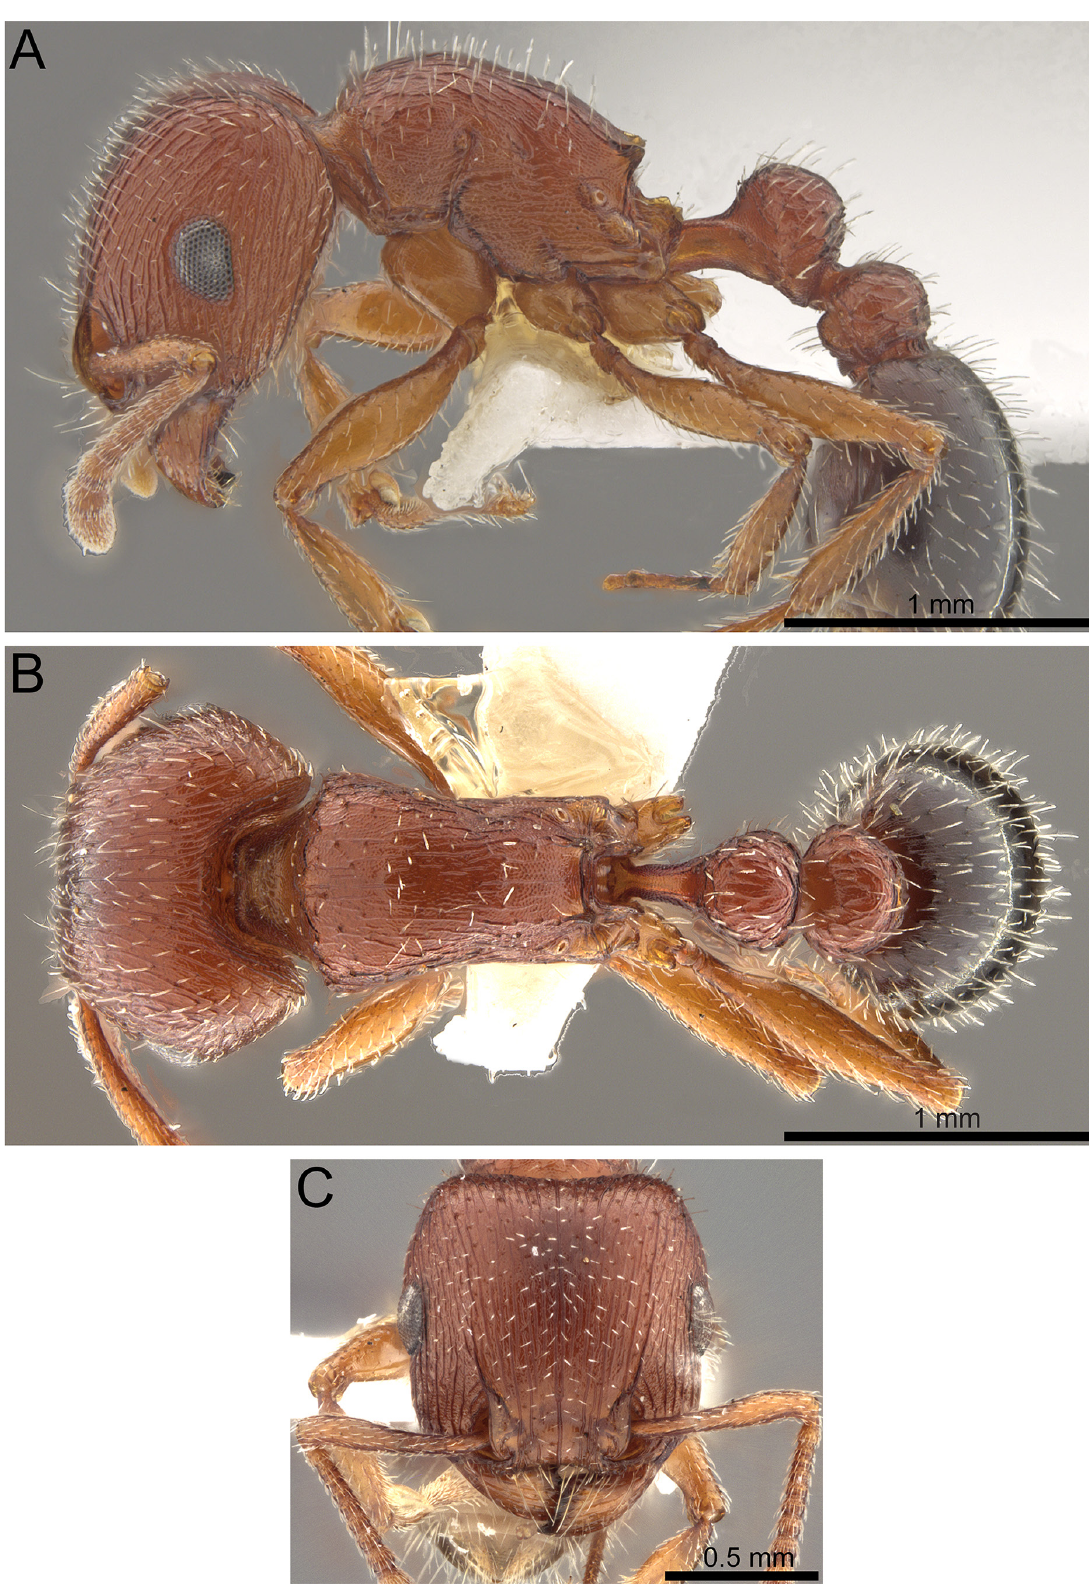
Fig. 7. Tetramorium brigitteae Mbanyana, Robertson & Hita Garcia sp. nov. (SAM-HYM-C027040). A . Body in profile. B . Body in dorsal view. C . Head in full-face